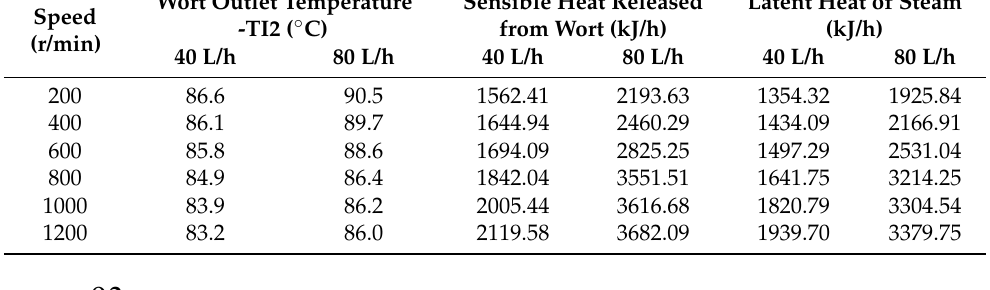
Table 2. Changes in the wort outlet temperature and energy consumption.